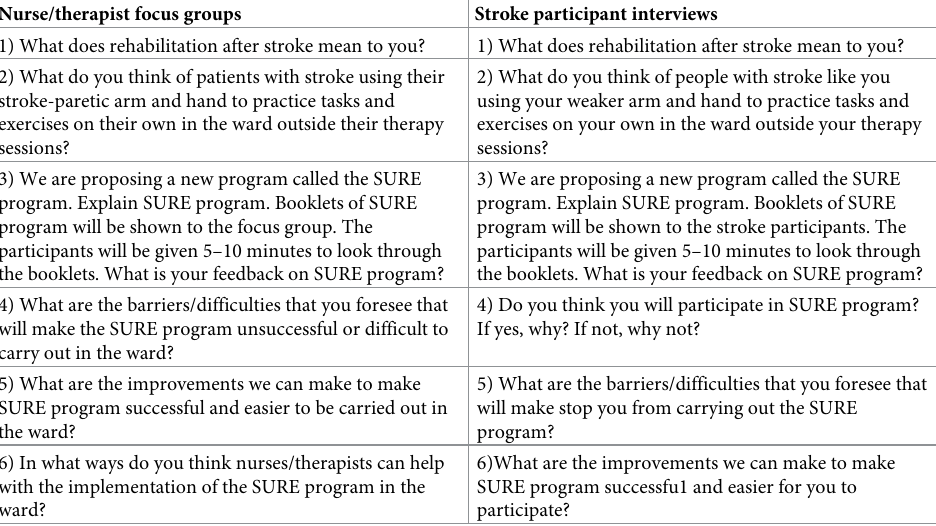
Table 1. Stimulus questions for nurse and therapist focus groups and stroke participant